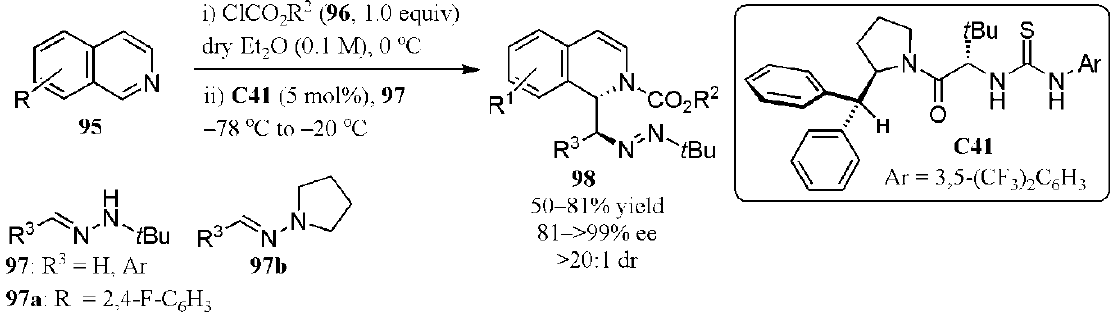
Figure 50. Asymmetric addition of N - tert -butylhydrazones to isoquinolinium ions [98].